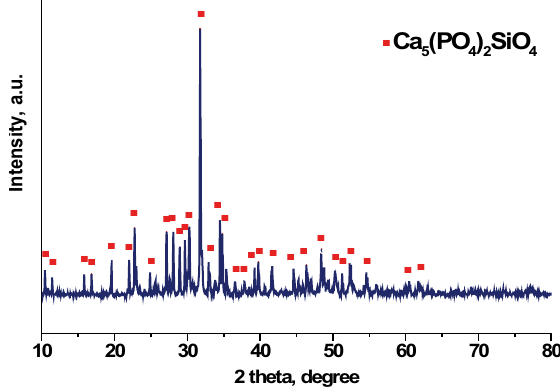
Figure 1. XRD patterns for silica containing sample, thermal treated at 1200 o C / 2 h